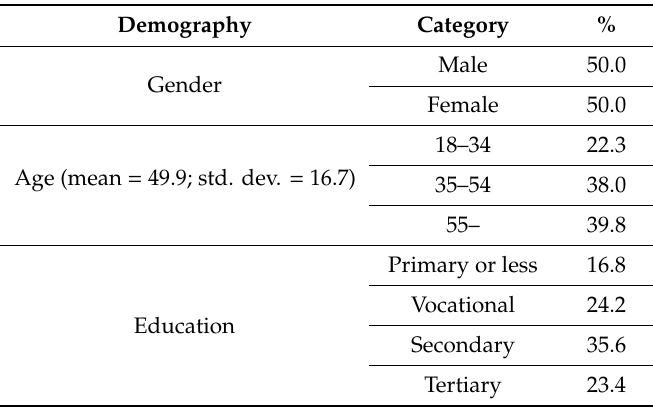
Table 2. Demographic structure of the sample 2